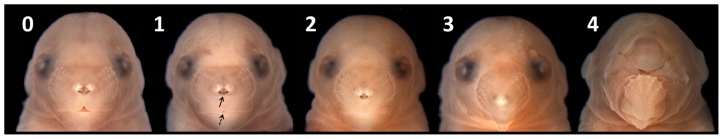
Facial dysmorphology rating scale.Illustrated are a GD 17 fetus having normal facial morphology and 4 fetuses with varying degrees of medial facial deficiency. Numbers assigned to each image (0–4) are scores representing differing degrees of severity of facial dysmorphology. As compared to normal fetuses, those receiving a score of 1 had a notably diminished area of pigmentation between the nostrils (solid arrow) accompanied by reduction in the depth of the normally present median central notch of the upper lip (dashed arrow). A score of 2 was assigned to fetuses that had lost the median lip notch, but still had some remaining pigment at the tip of the nose. Individuals presenting with a single central nostril were assigned a score of 3 and those given a score of 4 had no nostrils.